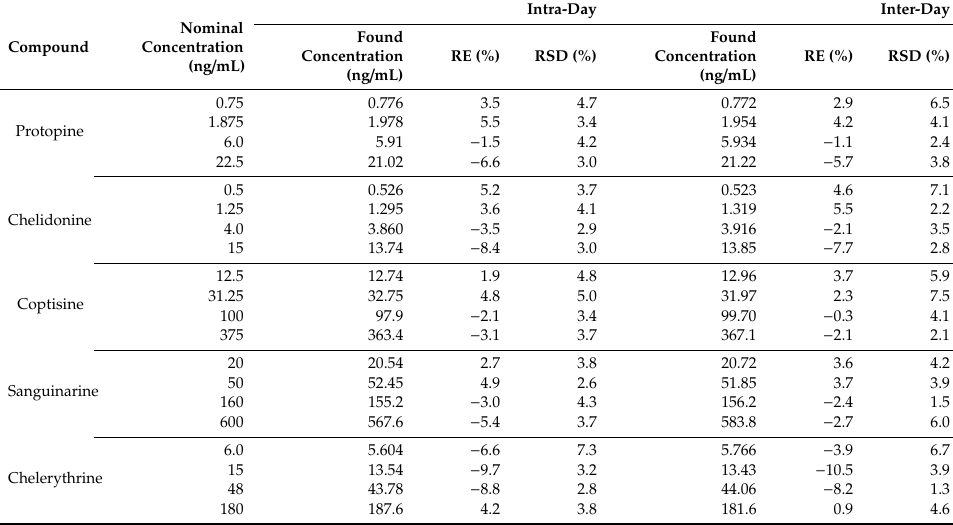
Table 2. Precision and accuracy of the determination of five alkaloids in cell lysates by LC–MS / MS analysis. RSD: relative standard